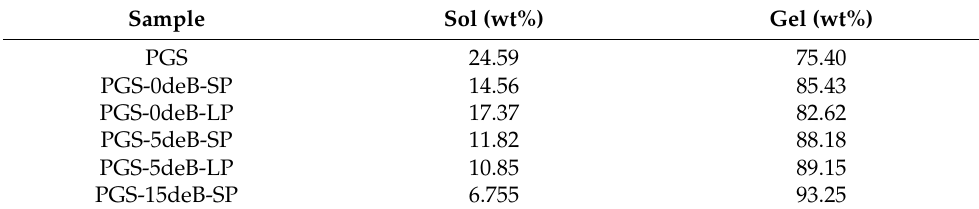
Figure 6. The crosslinking density of all the PGS-deB blend scaffolds and PGS film; the sol fractions % (non-crosslinked content) of the PGS film and PGS-deB blend scaffolds were determined via sol– gel content; * p < 0.05; ** p ≤ 0.01 and *** p ≤ 0.001 indicates statistical significance and each data have plotted as geometrical symbols on bars (n=3). Table 3. Sol–Gel Content. Table 3. Sol–Gel Content.